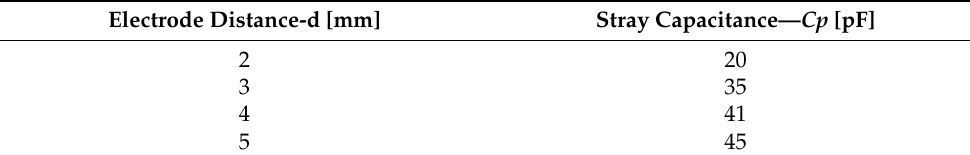
Table 5. Values of stray capacitance in the SDBD system.